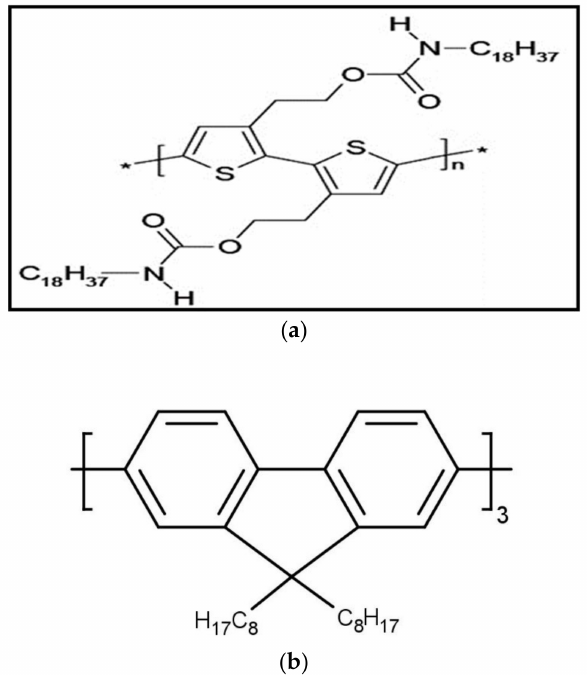
Figure 1. Molecular structure of ( a ) poly[3-(2-ethyl-isocyanato-octadecanyl)-thiophene] (TCP) polymer and ( b ) 9,9,9 (cid:48) ,9 (cid:48) ,9 (cid:48)(cid:48) ,9 (cid:48)(cid:48) -hexakis(octyl)-2,7 (cid:48) ,2 (cid:48) ,7 (cid:48)(cid:48) -trifluorene (HOTF)